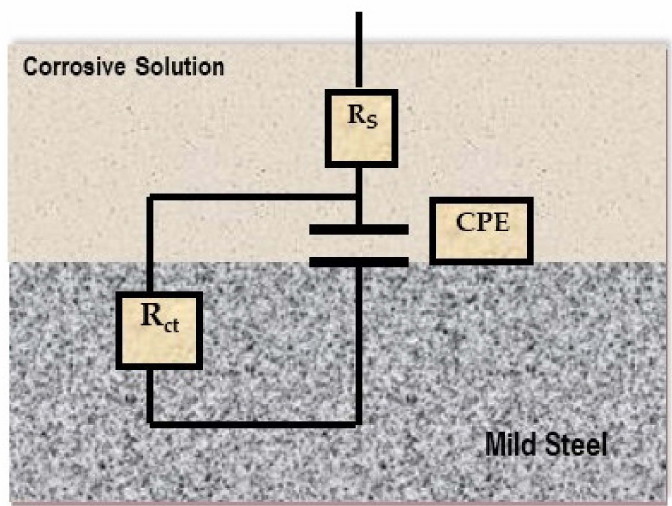
Figure 4. Equivalent circuit used for fitting the